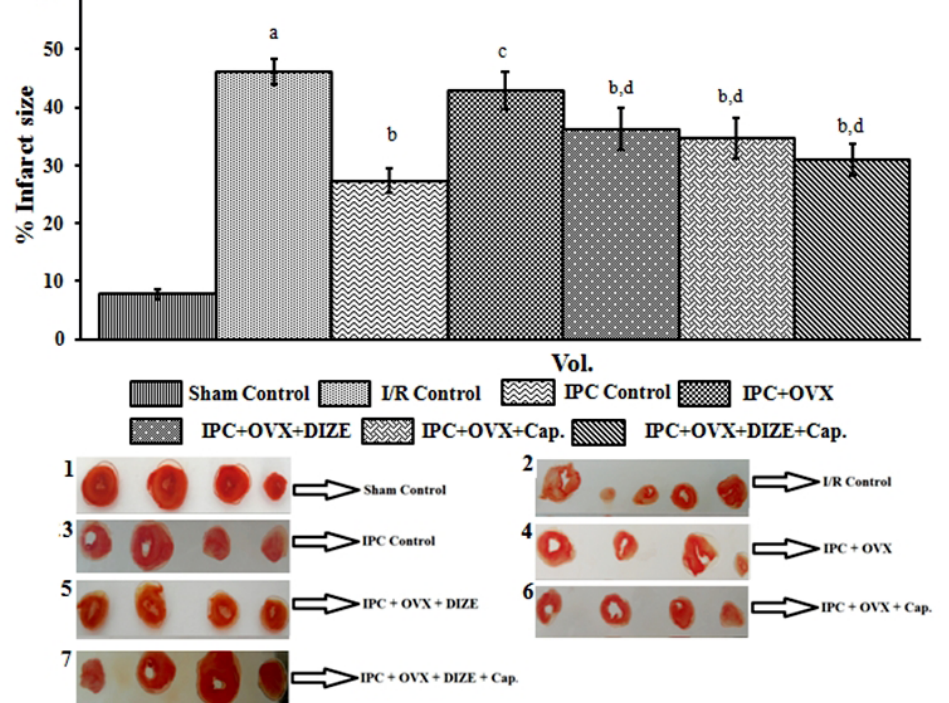
FIGURE 2 - Myocardial infarct size with Images of the TTC-stained sections of the heart (1-7); Effect of I/R on myocardial infarct size, the effect of ischemic preconditioning (IPC) on myocardial infarct size in normal and OVX rat heart, the effect of DIZE perfusion on myocardial infarct size in ovariectomized rat heart and effect of Cap. alone or in combination with DIZE on myocardial infarct size in OVX rat heart. I/R denotes ischemia-reperfusion; IPC denotes ischemic preconditioning; OVX denotes ovariectomy; DIZE denotes diminazene aceturate; Cap. denotes captopril. Values are expressed as mean ± S.D, a = p< 0.05 vs. Sham control; b = p< 0.05 vs. I/R control; c = P< 0.05 vs. IPC in normal rat heart; d = p< 0.05 vs. IPC in OVX rat